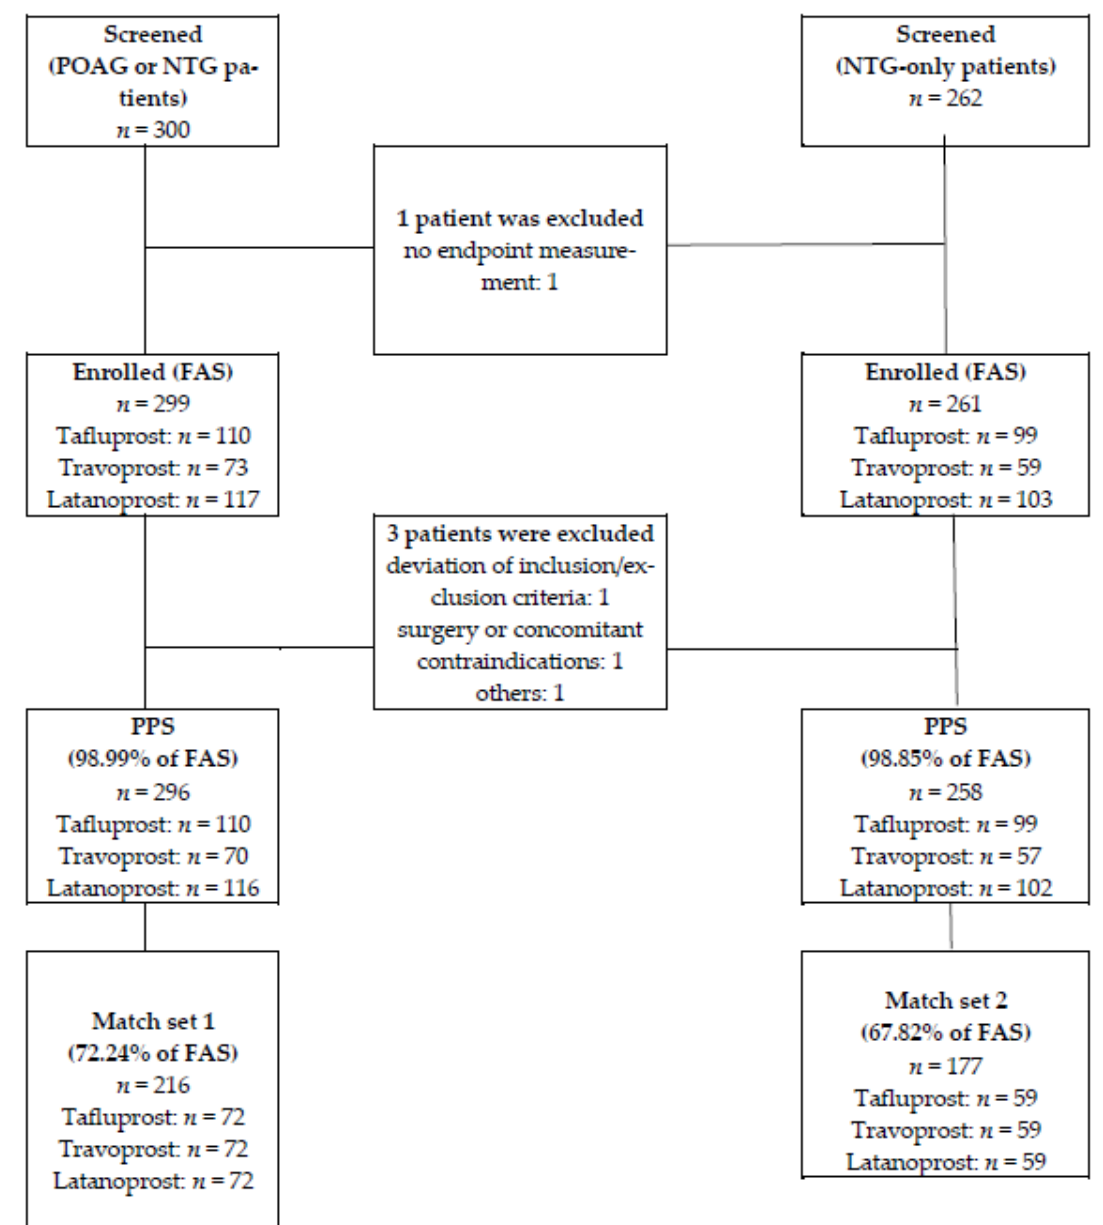
Figure 2. Disposition of POAG or NTG patients (Match Set 1) or NTG-only patients (Match Set 2).